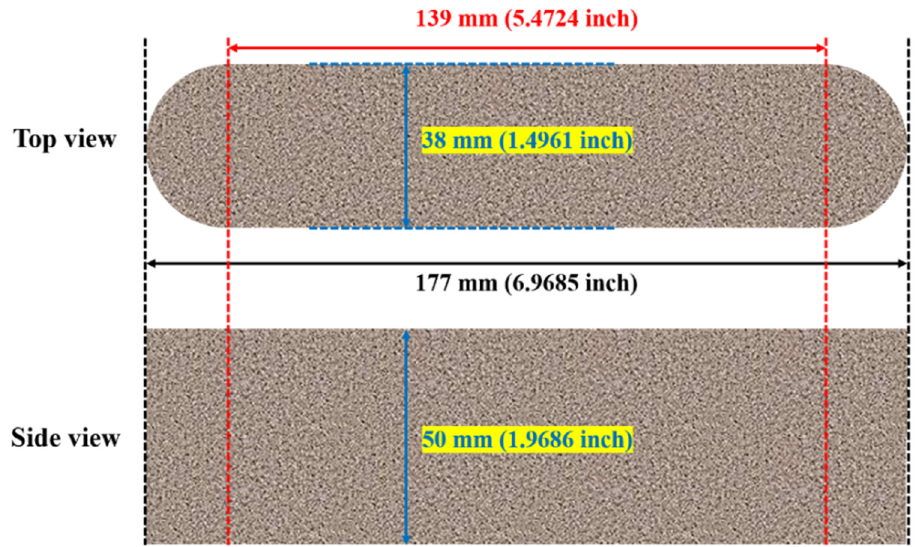
Figure 1. The size of the limestone